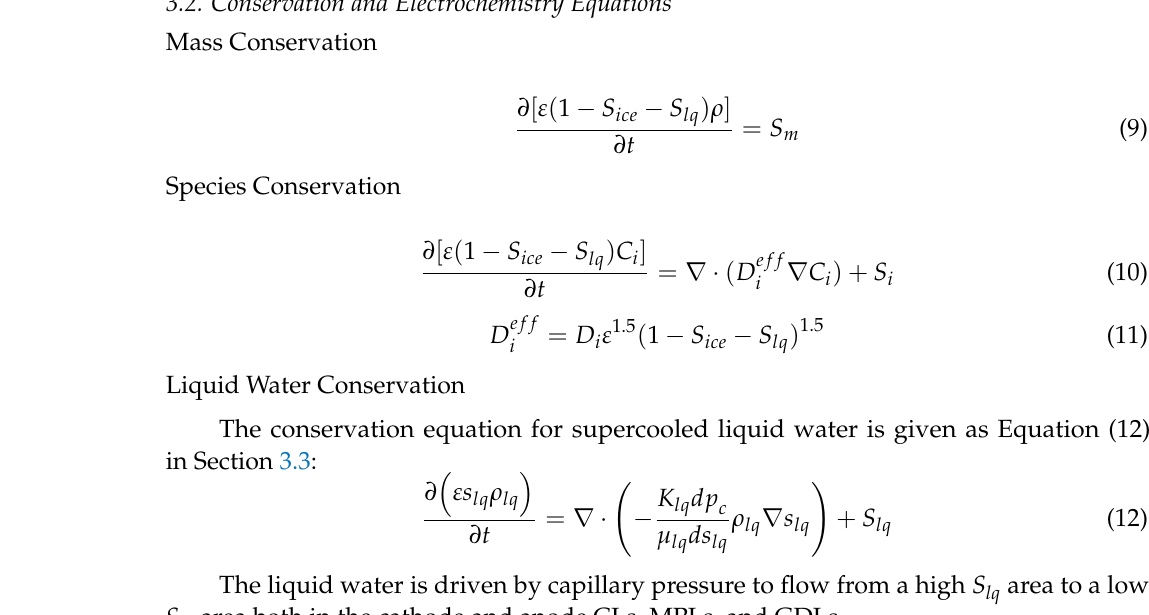
Figure 3. The structure of the complete mathematical model in this 2D model; the gases flowing in the gas channels and the MEA are not considered; the momentum conservation equations are not solved; the convection terms in the equations of mass conservation, species conservation, liquid water conservation, and energy conservation are omitted; conversely, the gas species of hydrogen, oxygen, nitrogen, and water vapor are considered in the present model and their transports are described by the following conservation equations